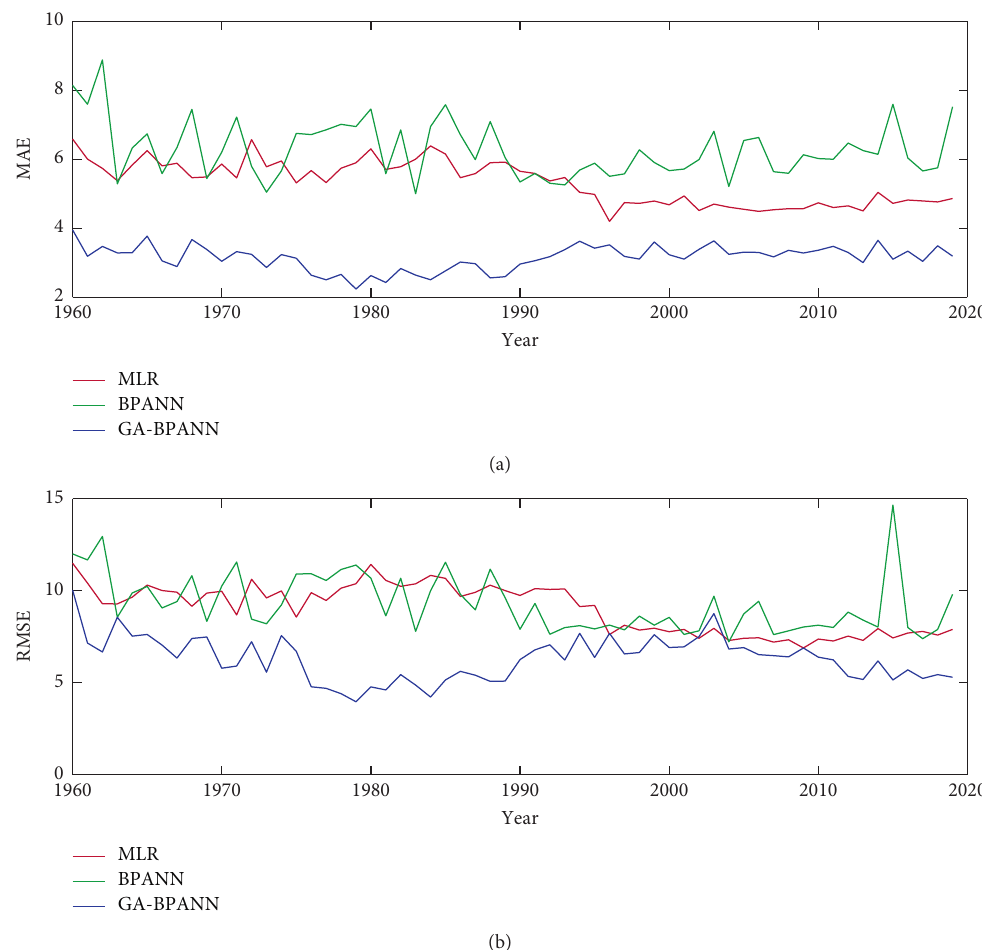
Figure 5: Annual variations of the MAEs and RMSEs associated with the three interpolation methods used for estimating monthly Antarctic SAT during the period 1960–2019. The annual MAE in a year is the average of monthly MAEs at all sites for all months in that year. The annual RMSE was calculated in the same